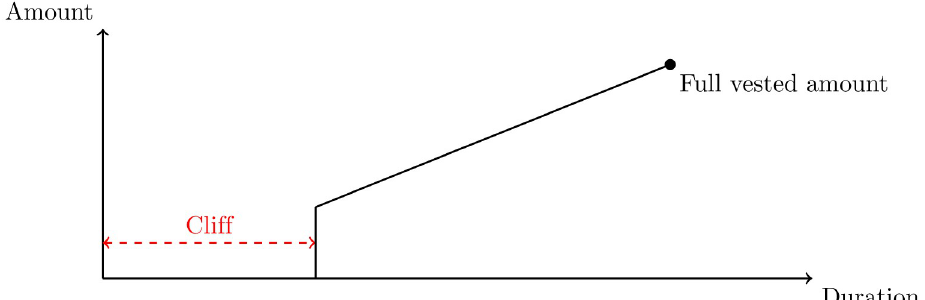
Fig 2. Example of a token vesting schedule using a combination of cliff vesting and graded